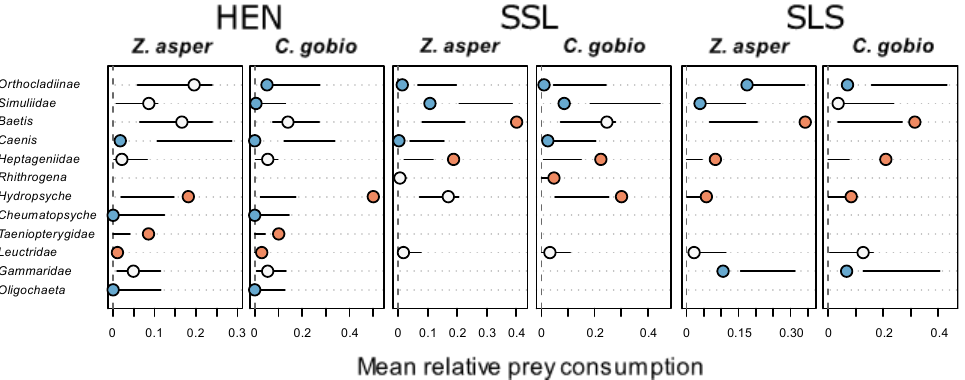
Figure 3. Zingel asper and Cottus gobio prey electivity. Dots represent the observed mean consump- tion, and bars indicate 95% CIs based on the null model. Red: significant positive electivity; Blue: significant negative electivity; White: not significant. N.B.: In order to avoid false positives, only abundant prey species were considered for electivity tests: i.e., >5% relative abundance in the diet and/or in the prey community.